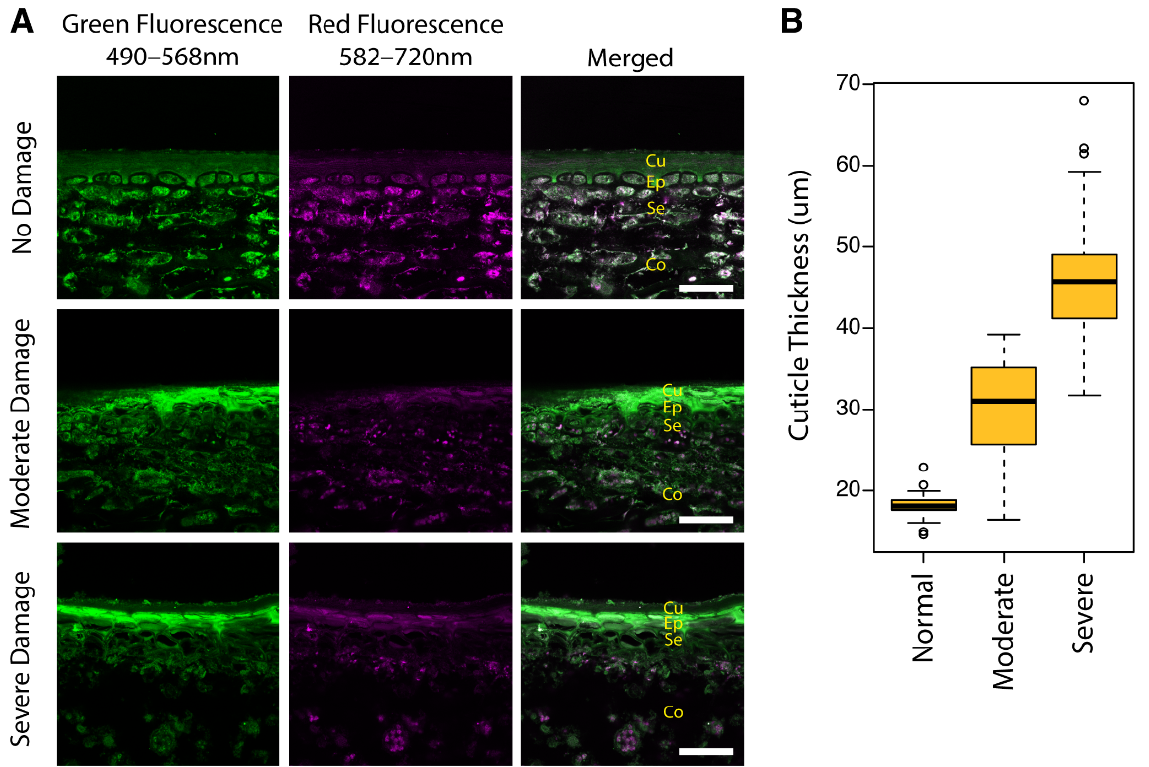
Figure 3. Sunburn damage results in the death and collapse of several layers of subepidermal cells and the increased thickness of the cuticular layer: ( A ) confocal micrographs of transverse sections of ‘Ambrosia’ apple peels exhibiting no, moderate, and severe sunburn browning damage. Cu, cuticle; Ep, epidermal tissue; Se, subepidermal tissue; Co, cortex. Scale bars = 50 µm; ( B ) Boxplot of measurements of cuticular thickness in the sun-exposed skin with no, moderate, and severe sunburn browning damage, as measured from the edge of the cuticle to the first living cell layer ( n = 50 measurements from 10 micrographs each; circles represent outliers).